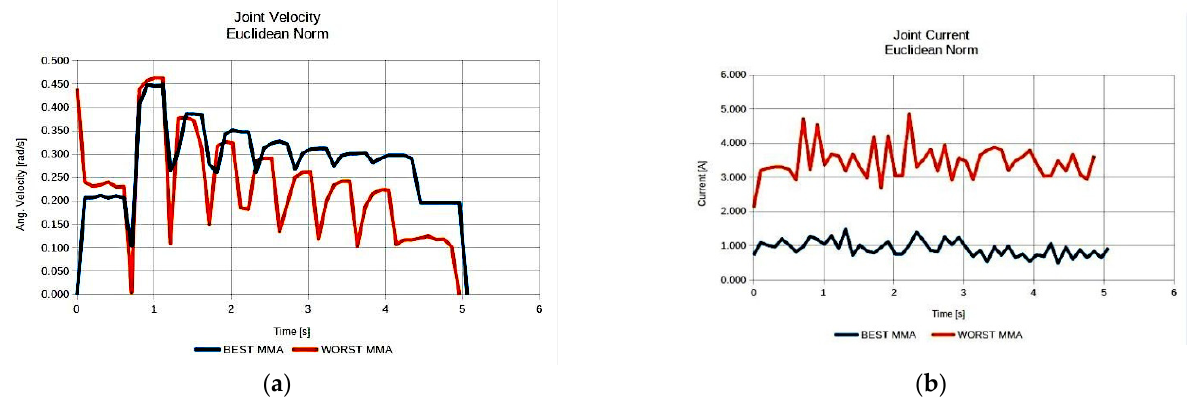
Figure 9. Comparison of the required joint velocities ( a ) and joint current usage ( b ) for the best anatomy and the worst performing anatomy under the MMA performance index for task 1.